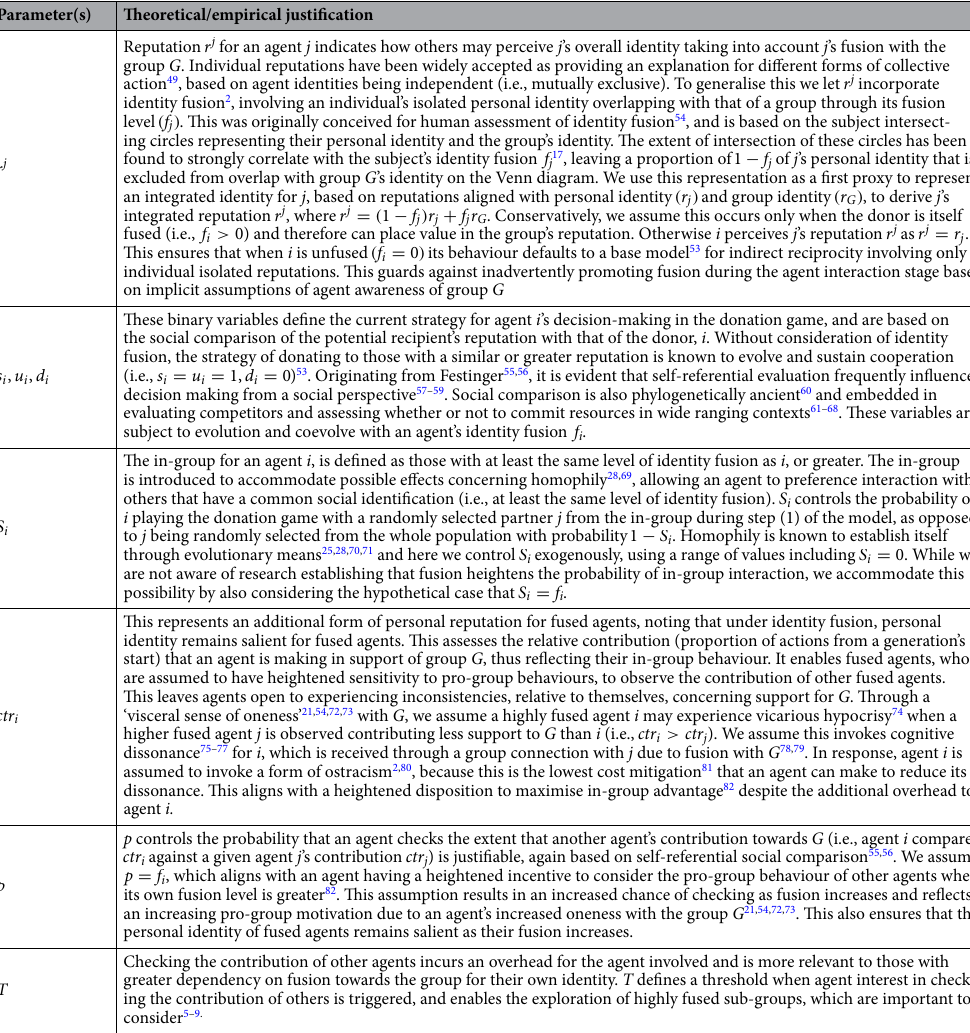
Table 2. Interpretation of the model’s key